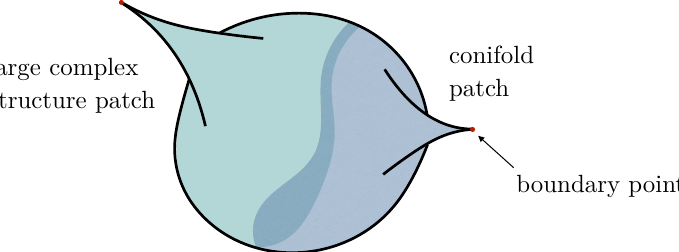
Figure 1: Schematic depiction of a complex one-dimensional moduli space. Two overlapping patches are indicated in light green and light blue. These can, for example, contain the large complex structure point and the conifold point of a Y 3